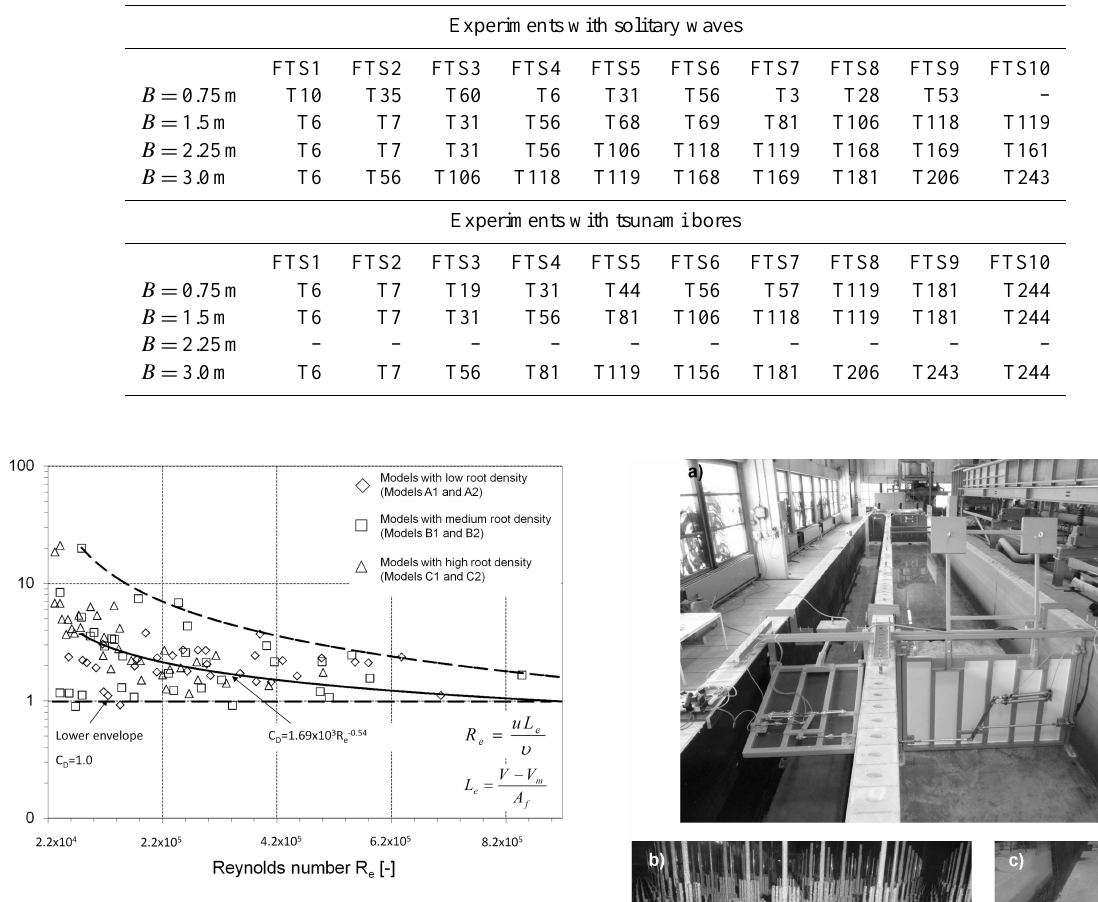
Fig. 3. Drag coefficient versus Reynolds number for the tests in quasi-steady flow flume (data corresponding to the “real mangrove models” A1, B1, C1 and the parameterized mangrove models A2, B2, C2 is considered only).